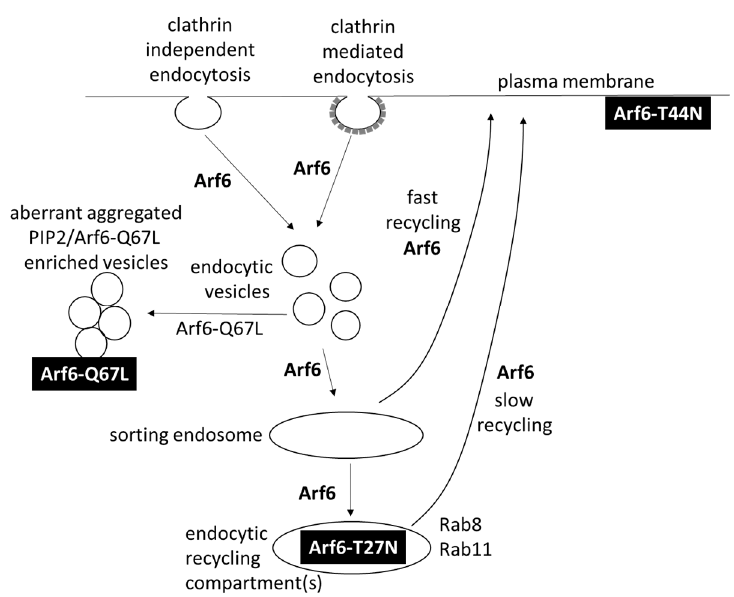
Figure 1. The role of Arf6 in intracellular trafficking upon clathrin-mediated endocytosis and clathrin-independent endocytosis. The location of Arf6 mutants in the cell is indicated as the white text on a black background.